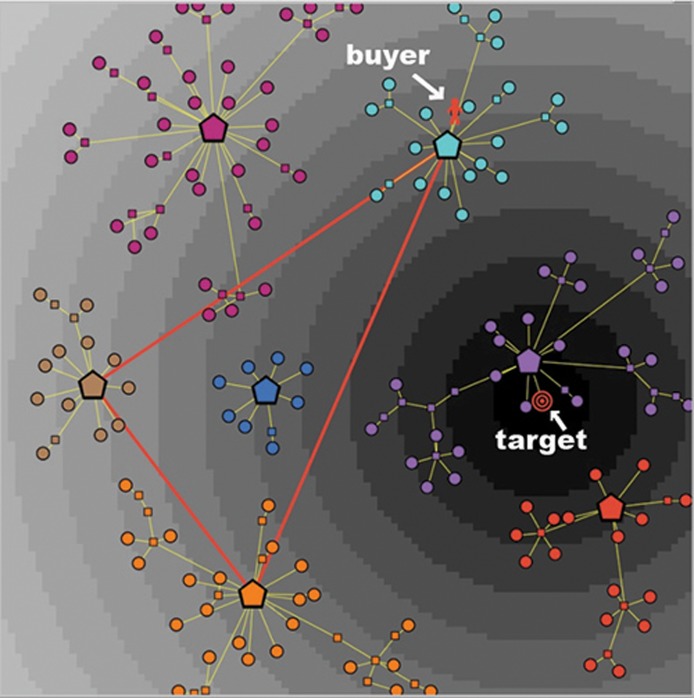
A market with seven clusters, as viewed by a consumer with moderate knowledge and high discrimination power.The consumer has a partial knowledge (Kn = 0.5) and a quite high number of indifference levels (NLev = 14), represented by annuli with different shades of gray. The indifference areas are centered at the target, which is located on a node, and is denoted by concentric red circles. The random initial position of the buyer is located on a node of the top-right cluster, and is denoted by a human shape.